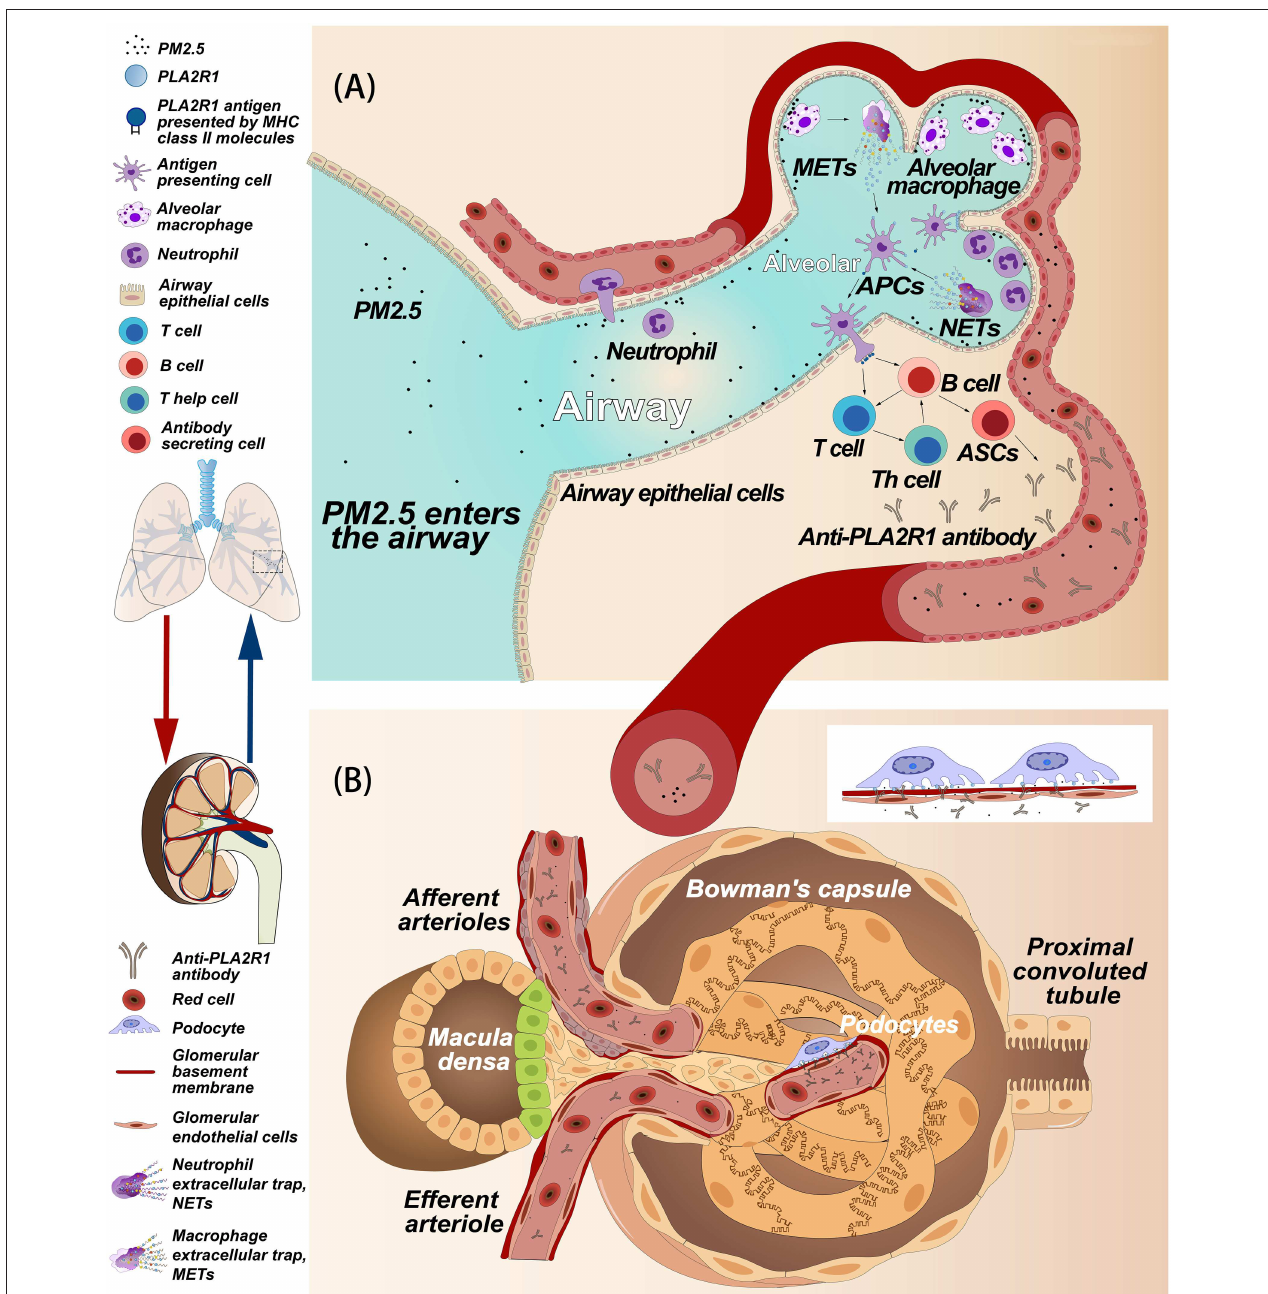
FIGURE 3 | Hypothetical model of the relationship between PM2.5 and membranous nephropathy. (A) Hypothesis of how PM2.5 induces anti-PLA2R1 antibody production. PM2.5 in the airways and alveoli causes an inflammatory response involving neutrophils, alveolar macrophages, and airway epithelial cells. We hypothesize that these cells may express PLA2R1, that due to oxidative stress associated with inflammation, may assume a conformation that includes pathogenic epitopes that contribute to the formation of autoantibodies. Alternatively, PLA2R1 may be released into the inflammatory space during the release of extracellular traps. PLA2R1 may then be bound by antigen presenting cells, triggering the humoral immune response, and producing anti-PLA2R1 antibodies. (B) The hypothetical process of subepithelial immune complex deposition caused by the anti-PLA2R1 antibody exogenous to glomeruli. Both PM2.5 and anti-PLA2R1 antibodies enter blood vessel and circulate into the glomerular capillaries. The anti-PLA2R1 antibodies penetrate the endothelial cells and glomerular basement membrane (GBM), recognize and bind to naturally-expressed PLA2R1 on podocytes to form the immune complex. These complexes then deposit into the space between podocytes and GBM.